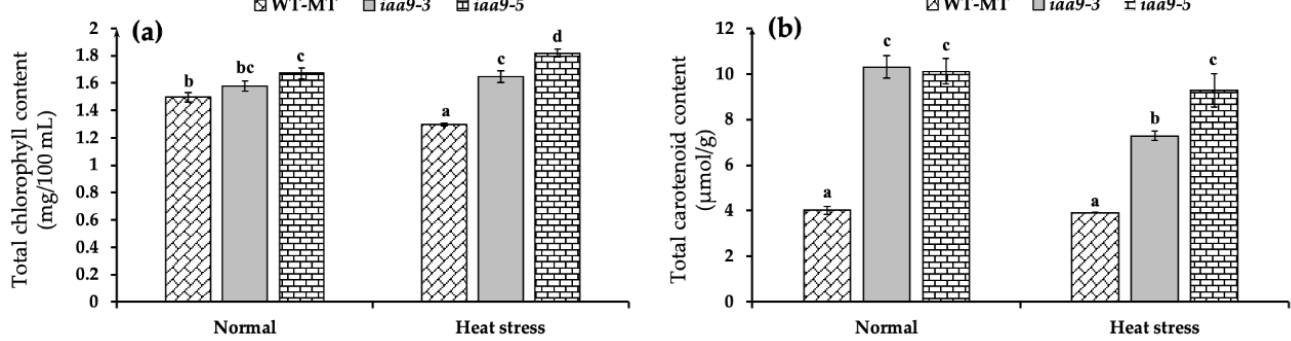
Figure 4. ( a ) Leaf total chlorophyll content of WT-MT, iaa9-3 , and iaa9-5 under normal and heat stress conditions; ( b ) leaf total carotenoid content of WT-MT, iaa9-3 , and iaa9-5 under normal condition and heat stress conditions. The average value ± standard error (SE) ( n = 4) followed by the same letter is not significantly different according to the Tukey-HSD test at 5%.